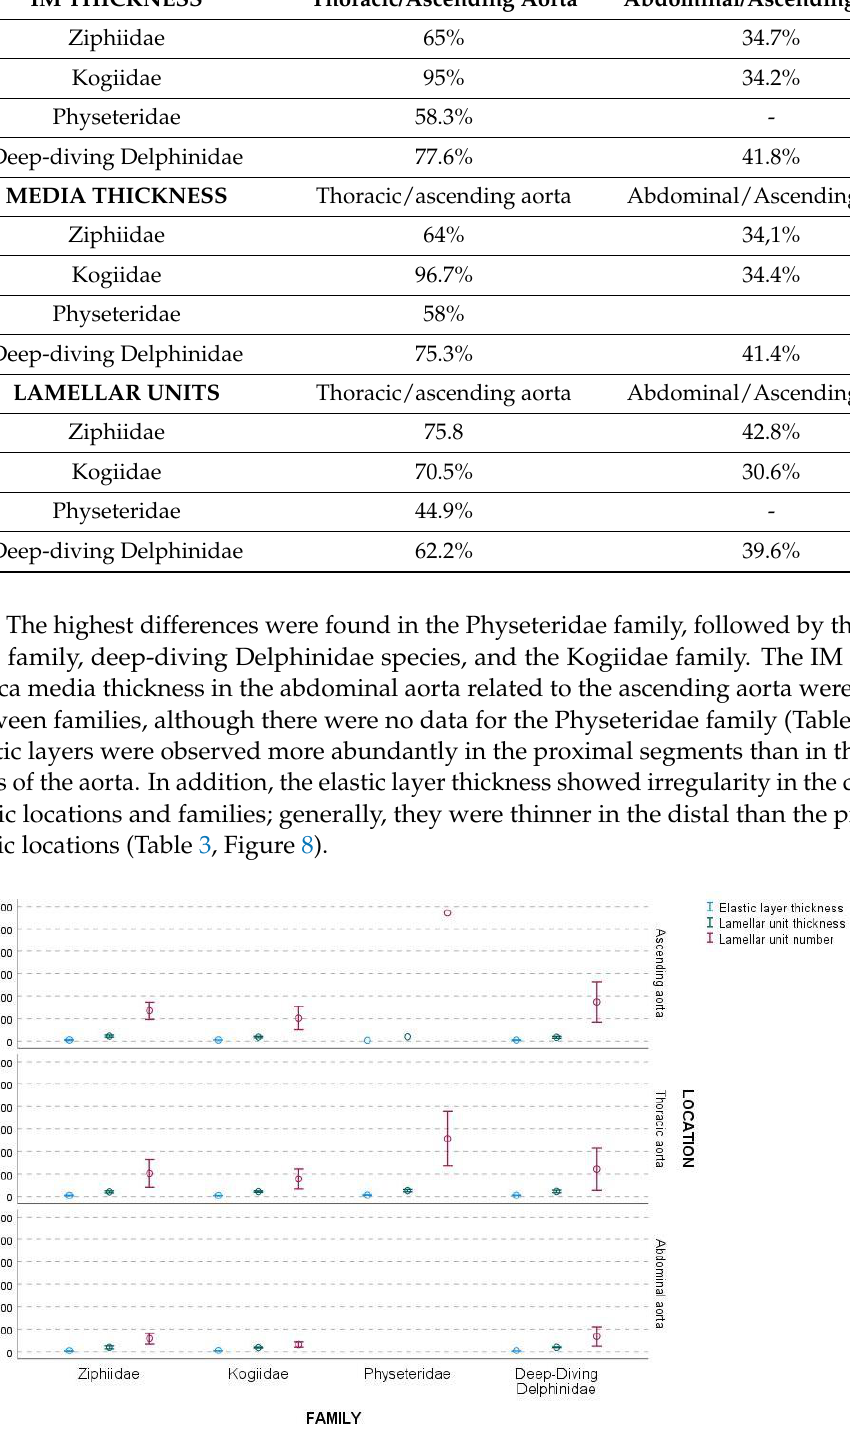
Table 5. Mean ± SD and maximum and minimum values in all the families.